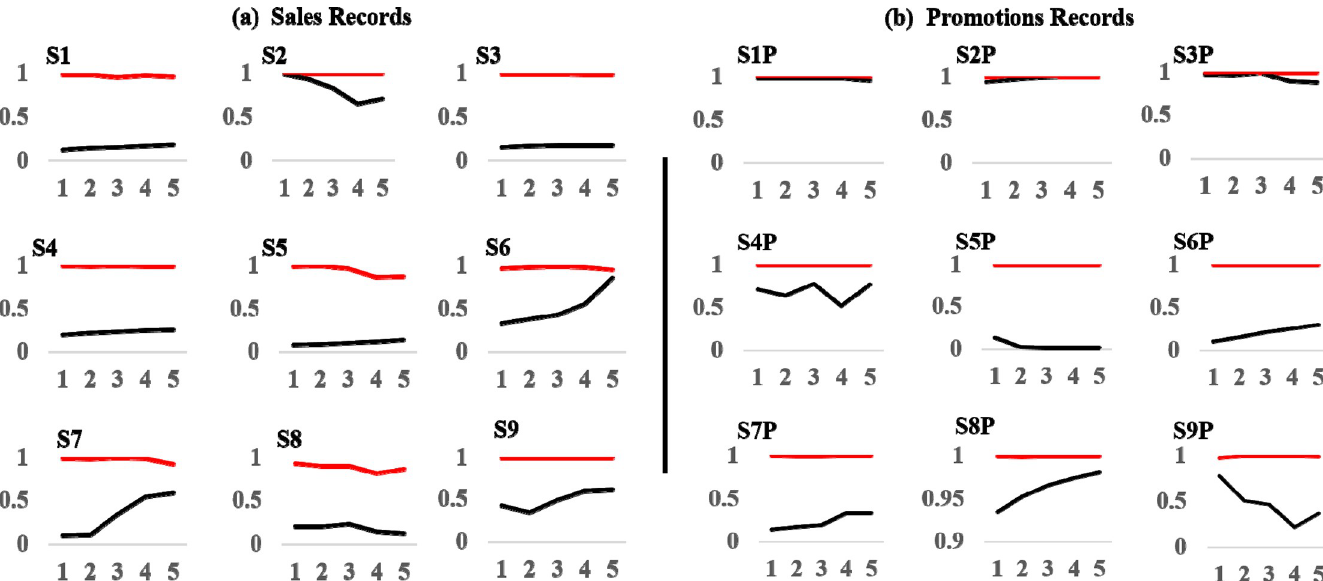
Fig 8. Results of nonlinear stationarity testing. We apply singular spectrum transformation [27] to test signals for stationarity required by NLTS. Change-point scores (black curves) rest below upper point-by-point 95% limits (red curves) constructed with surrogate data indicating for (a) sales records and (b) promotion records except for S2P. This indicates that S2P is nonstationary due to a significant change point in its dynamic structure, and we delete it from further NLTS diagnostics.